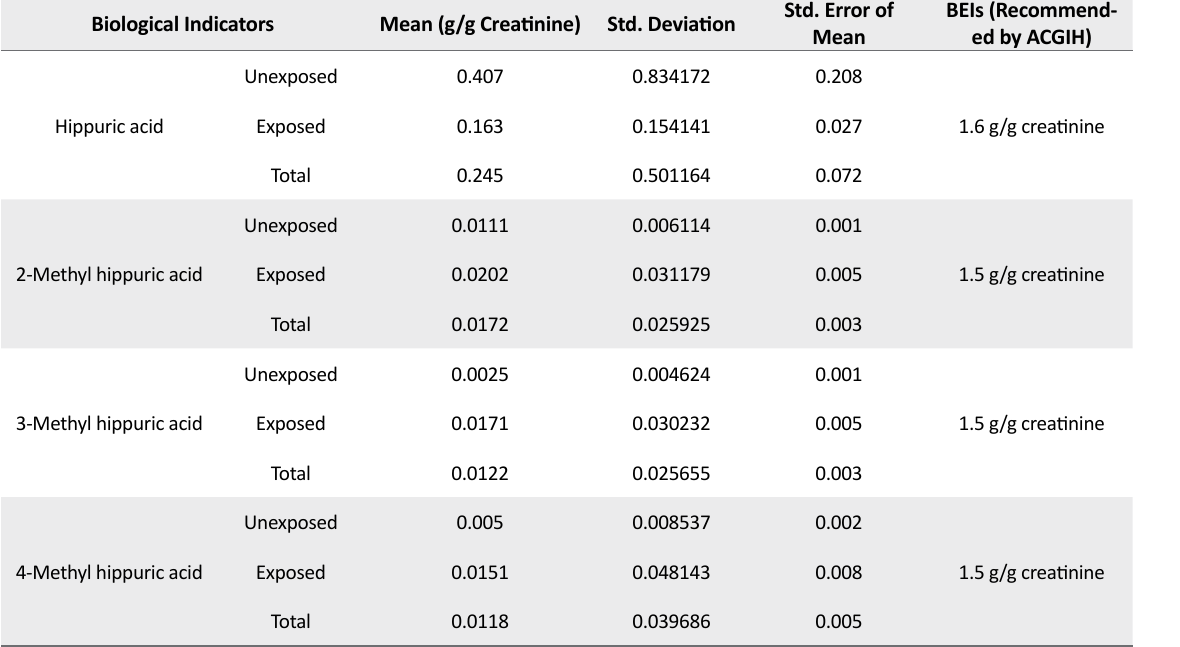
Table 4. Mean ± SD, MSE, HA, 2-, 3-, and 4-MHA in the urine of the exposed and control groups obtained by ANOVA test Biological